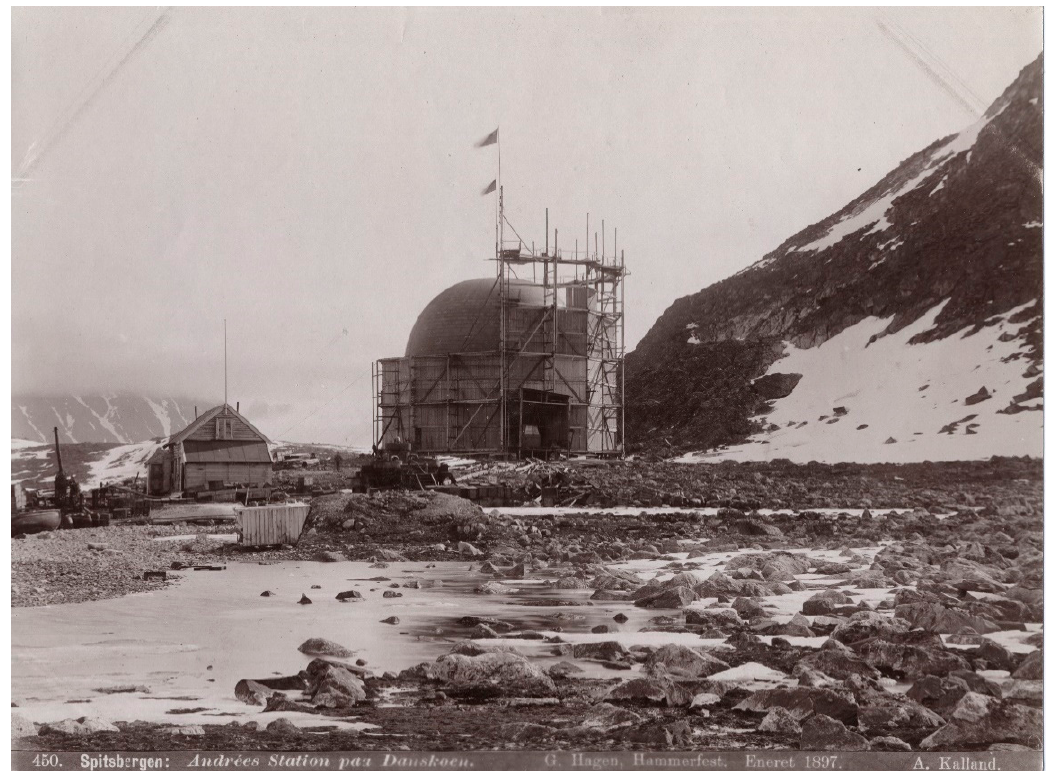
Figure 2. Virgohamna was a base for several famous expeditions attempting to reach the North Pole in the late 1800s and early 1900s. Picture taken in 1897 by Ludvig Blunck. © Norwegian Polar Institute. Humanities 2019 , 8 , 21